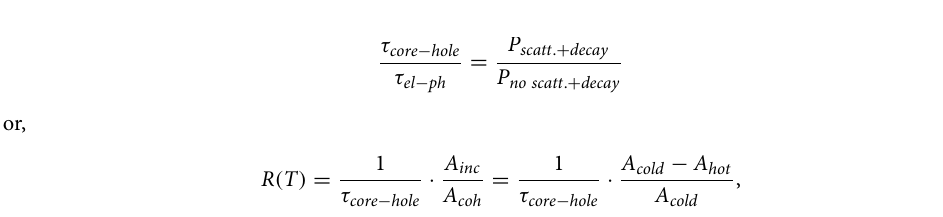
Figure 1. Temperature-dependent XES of nickel. Temperature dependent Ni L -edge XES spectra in Fe 20 Ni 80 and Fe 50 Ni 50 are shown in ( a ) and ( b ) respectively. The insets are zoom in of the 3 d → 2 p 3 / 2 peak. An increase of the temperature leads to a reduction of intensity of the 3 d → 2 p 3 / 2 peak. ( c ) XAS spectrum of nickel. The arrow indicates the photon energy used for the XES